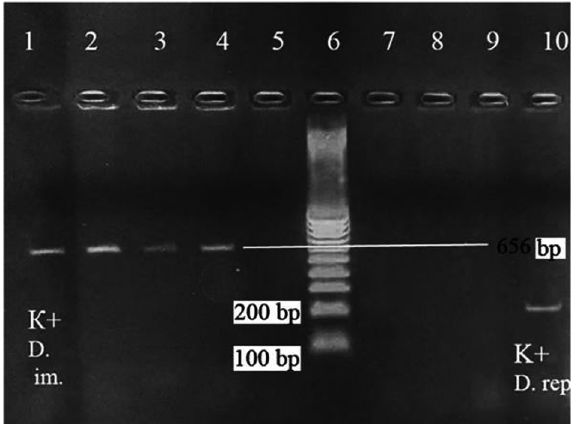
Figure 2. Amplicon products on agar gel electrophoresis. Lane 1, positive control of Dirofilaria immitis ; lanes 2–4, samples from the worm removed from the patient and amplified by D. immitis specific primers; lane 5, negative control; lane 6, molecular mass marker; lanes 7–9, samples from the worm removed from the patient and amplified by Dirofilaria repens specific primers; and lane 10, D. repens positive